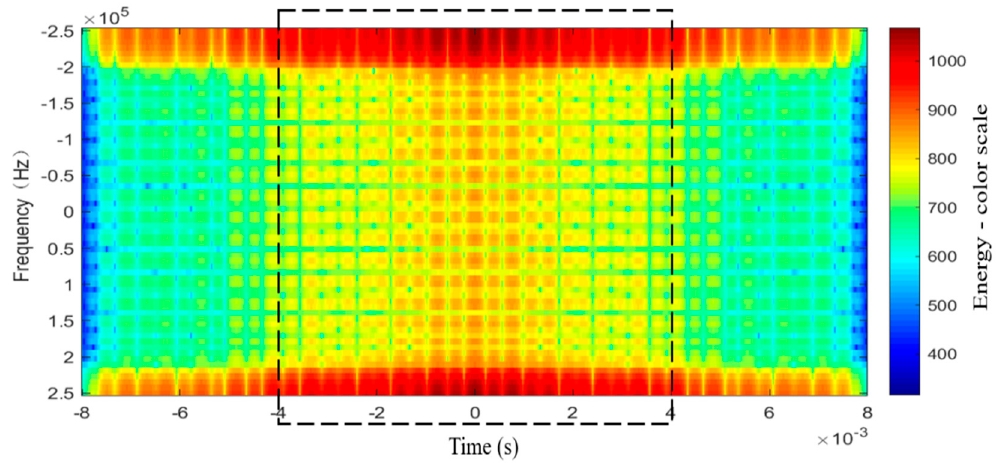
Figure 5. Time–frequency spectrogram (black dotted box indicates the region of interest (ROI)